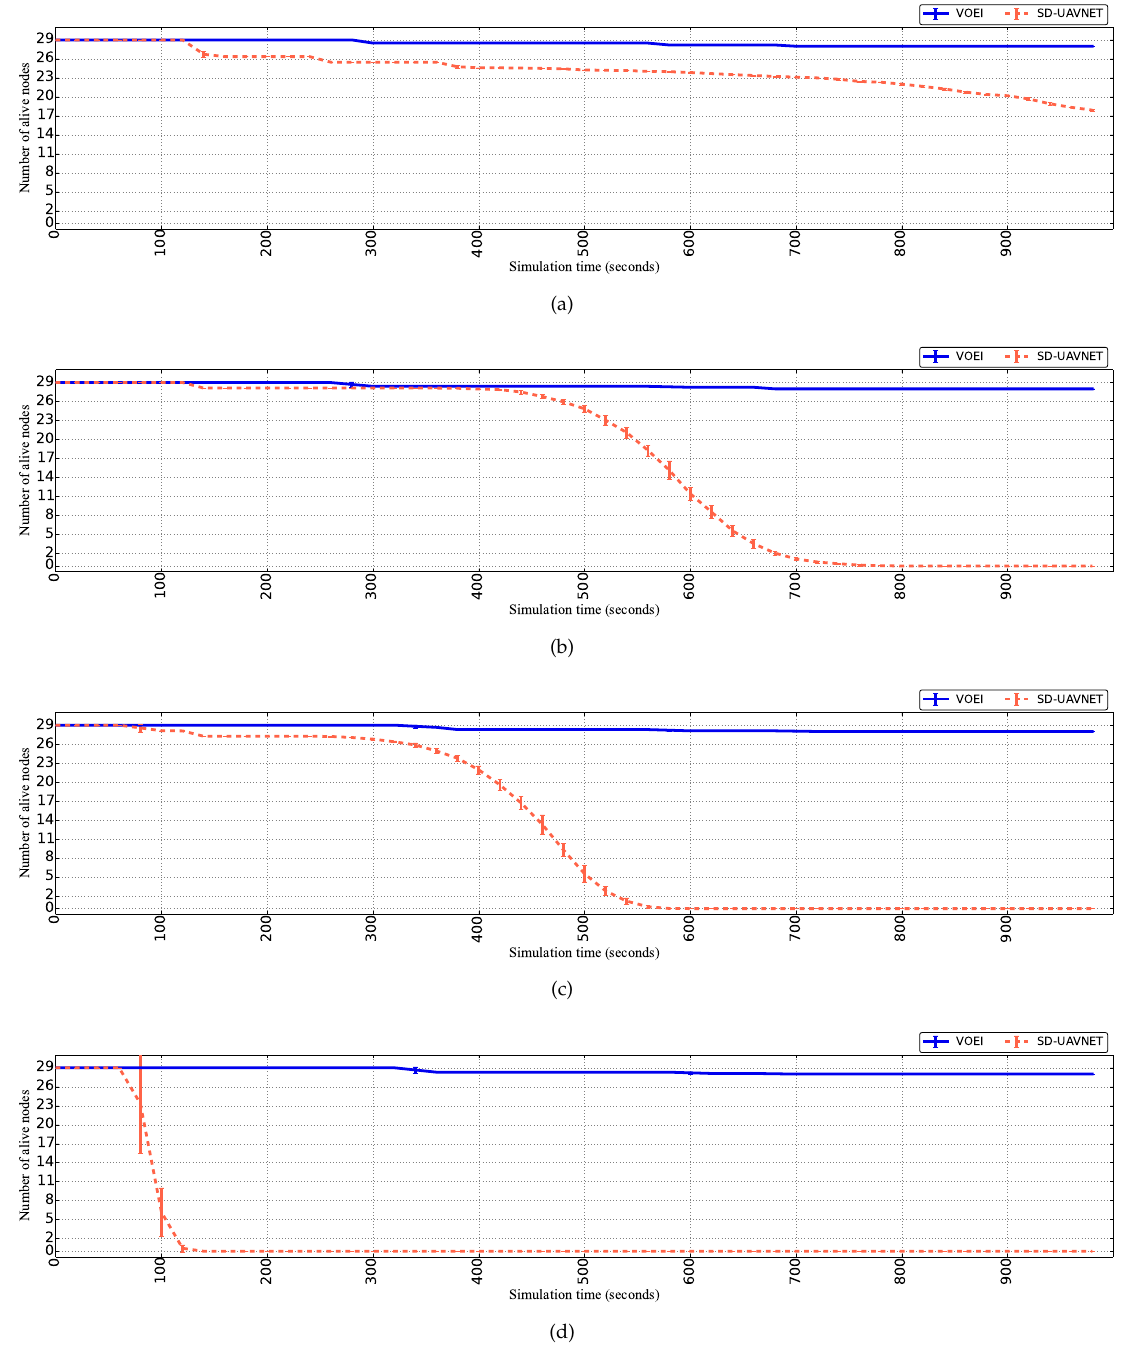
Figure 3. Number of live UAVs over time for UAVs flying with different speed limits. ( a ) UAVs flying with speed raging from 1 to 5 m/s; ( b ) UAVs flying with speed raging from 5 to 10 m/s; ( c ) UAVs flying with speed raging from 10 to 15 m/s; ( d ) UAVs flying with speed raging from 15 to 20